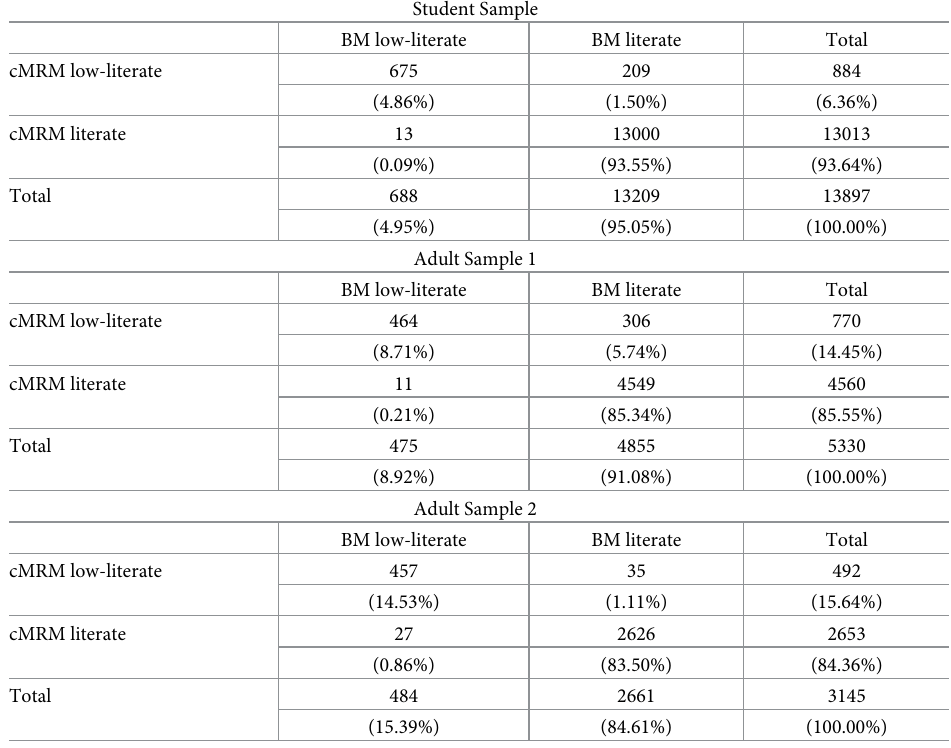
Table 4. Contingency table for agreement between the bookmark procedure (BM) and constrained Mixture Rasch Model (cMRM) in different